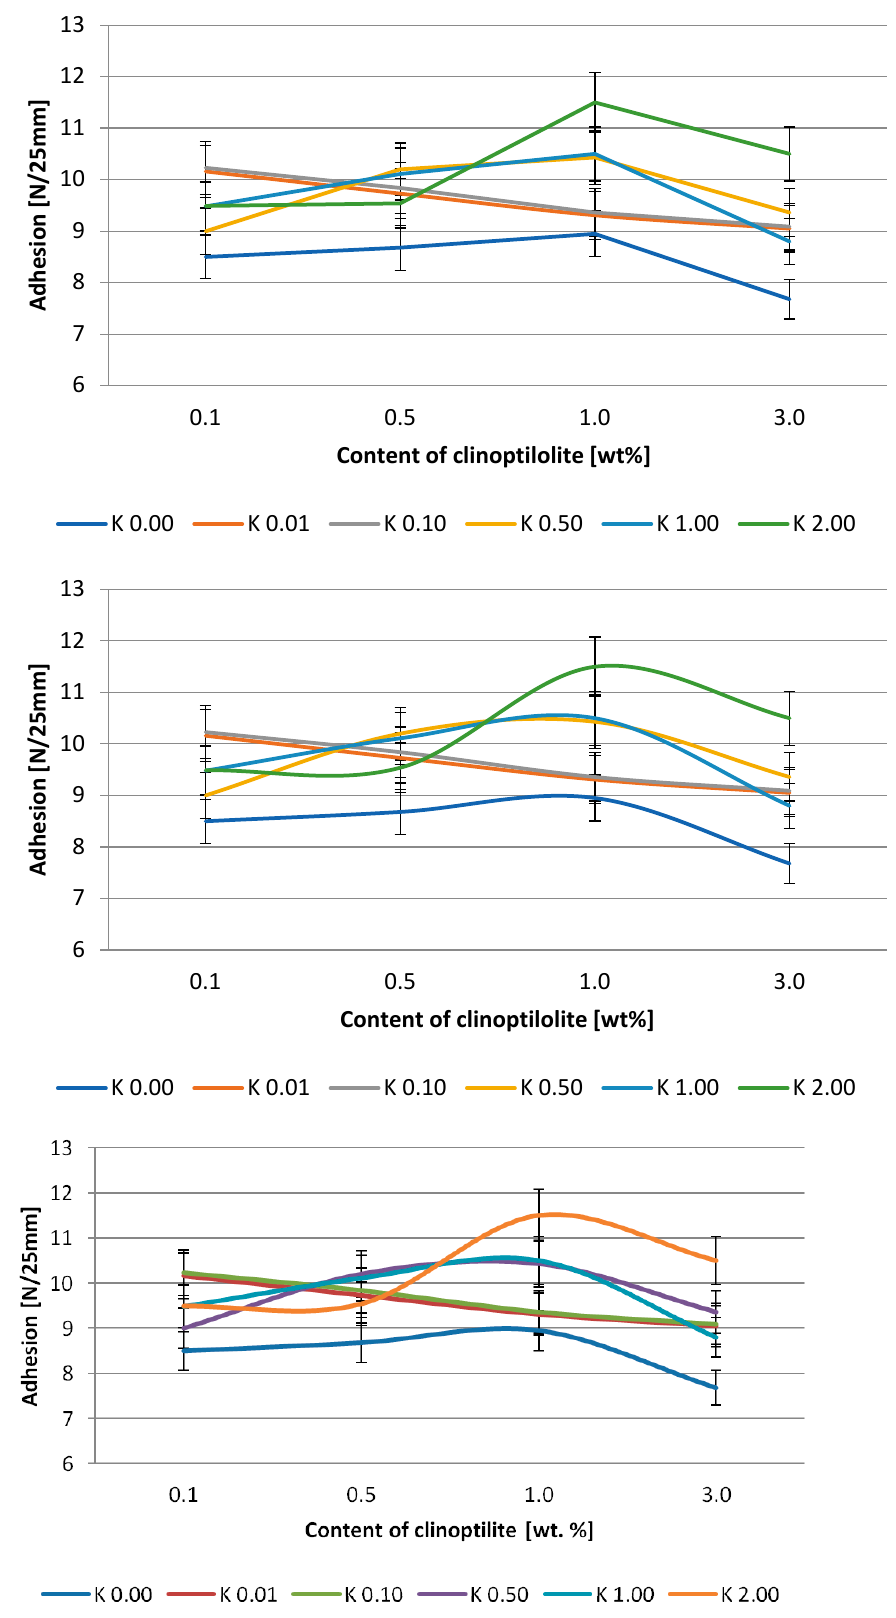
Figure 4. Effect of clinoptilolite content on the adhesion of silicone pressure-sensitive adhesives based on Q2-7355 resin.